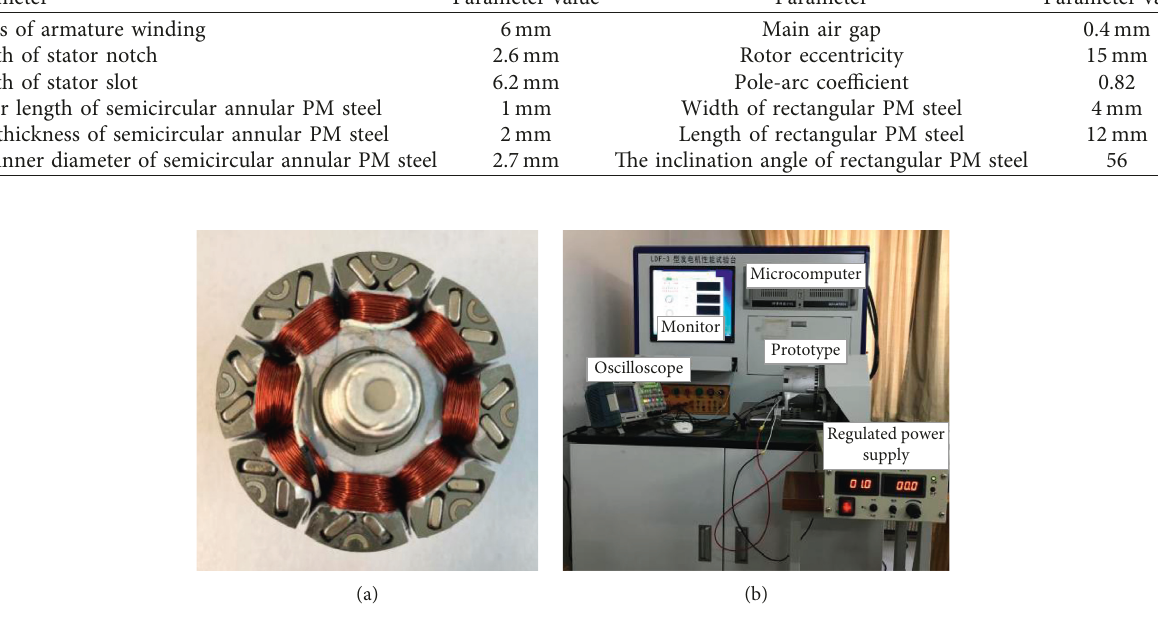
Figure 24: Prototype of designed HEG and test bench: (a) rotor; (b) test